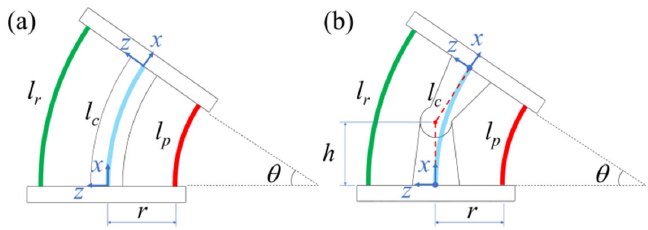
Figure 7. Diagram of wire length in a single joint: ( a ) conventional curvature model; ( b ) modified model with joint structure.